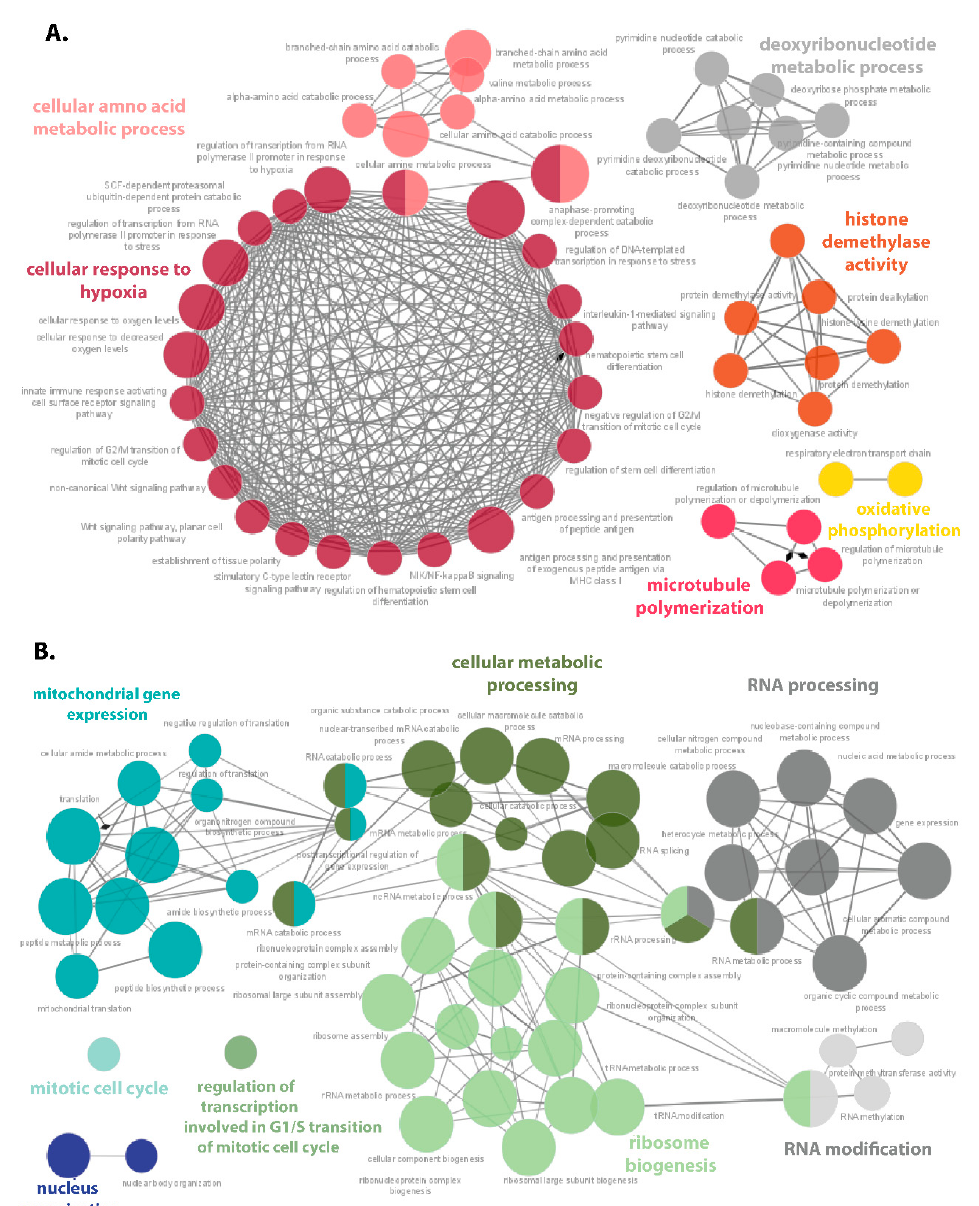
Figure 7. Protein–protein interaction networks of upregulated ( A ), and downregulated ( B ) proteins in Ri-1 cells under hypoxia (1% of O 2 ). The analysis was performed and visualized in ClueGO (v.2.5.7) Cytoscape App based on the Gene Ontology–Biological Processes (all updated 18 May 2020). Nodes (circles) indicate the pathway function groups, while edges represent connections between the nodes. Each node color represents a different pathway class that it belongs to. The node size represents the term enrichment significance, while the length of each edge shows the relevancy between two processes, p ≤ 0.05. The overlapping areas are the shared pathways of two groups. The details of analysis are provided